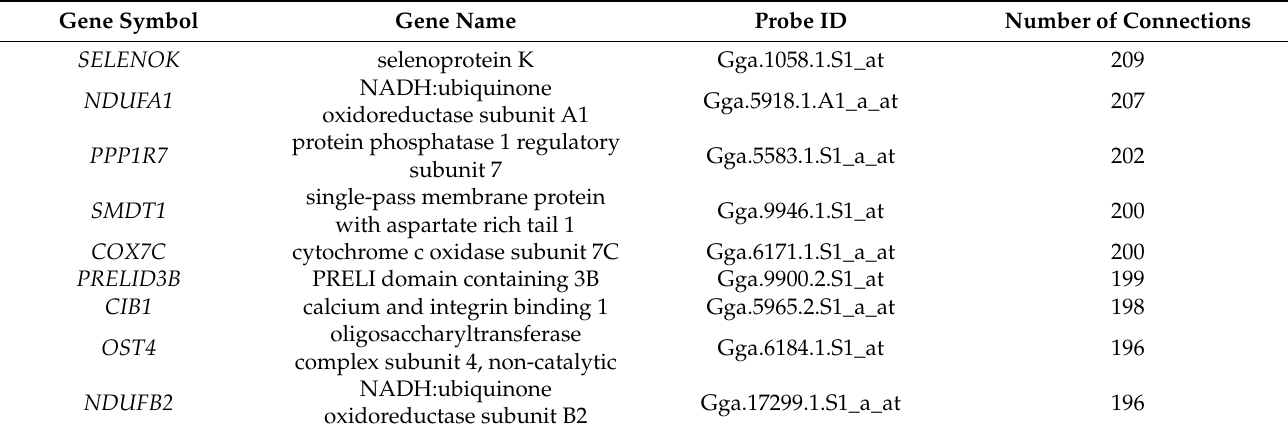
Table 4. Hub genes for all up-regulated data.